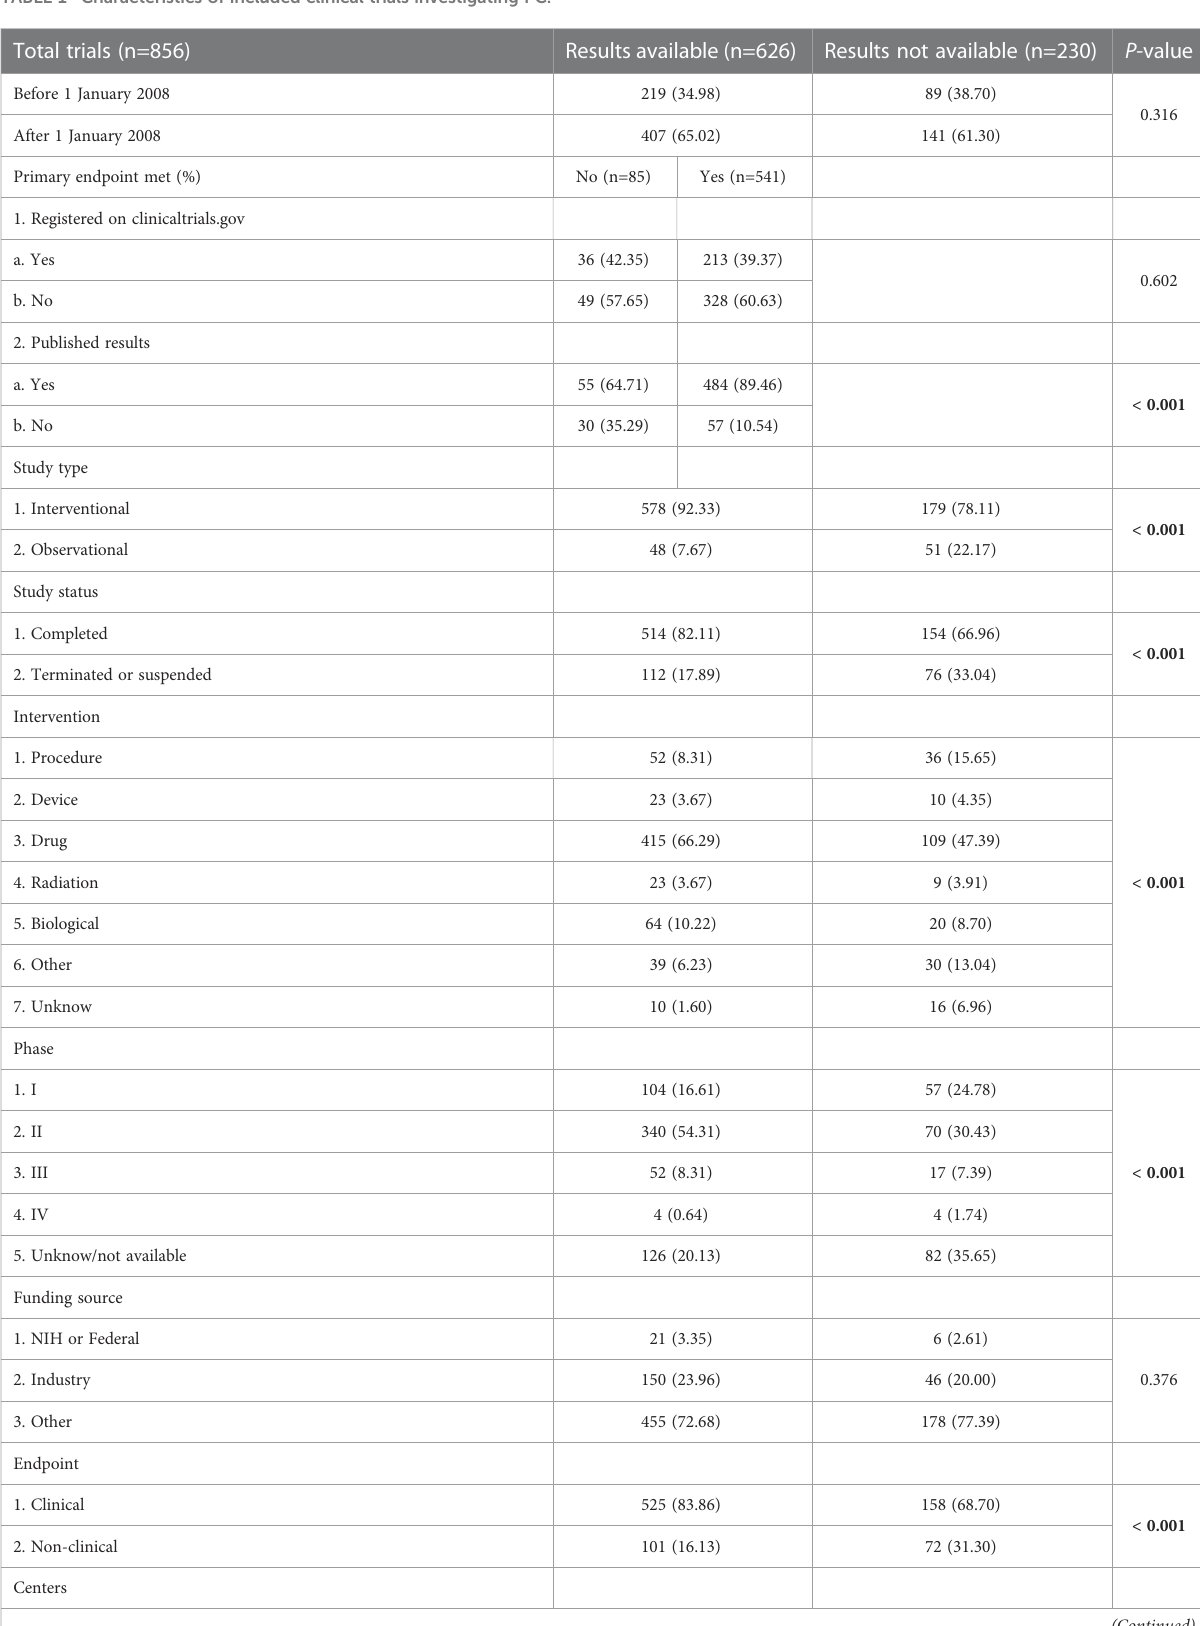
TABLE 1 Characteristics of included clinical trials investigating